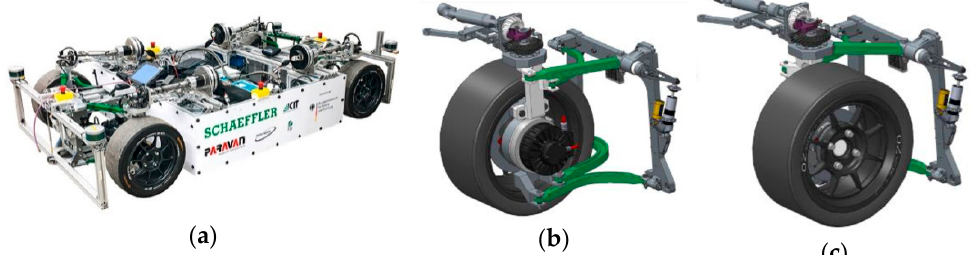
Figure 14. ( a ) Demonstration vehicle of project “OmniSteer”; ( b ) novel chassis system at increased steering angle 90°; ( c ) novel chassis system at increased steering angle –90°.